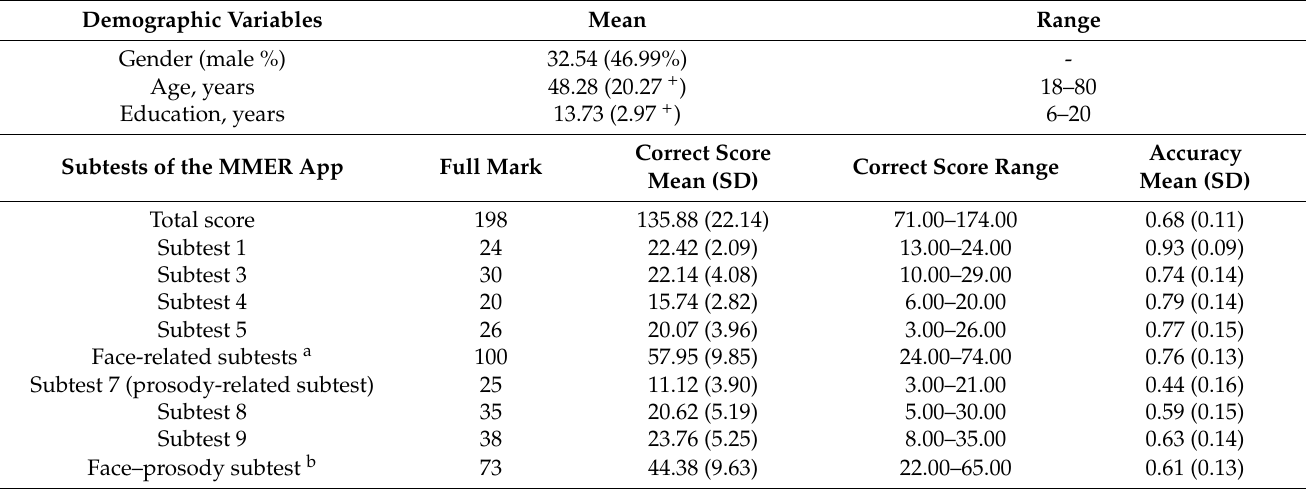
Table 3. The demographic characteristics and performance of participants in the MMER